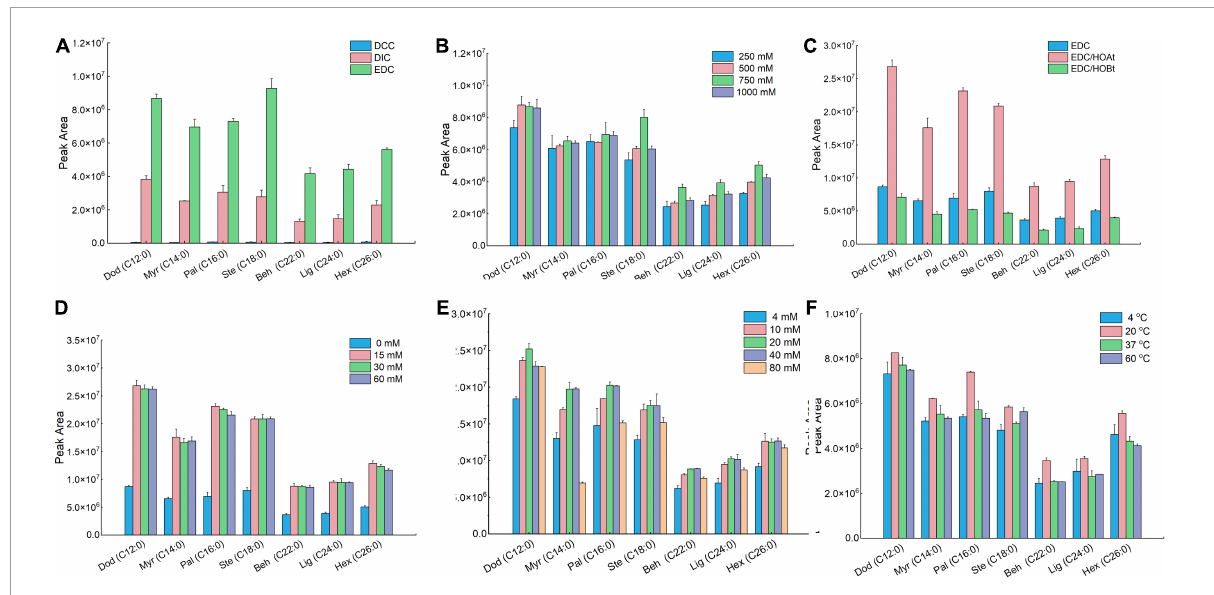
FIGURE2 Comparison of derivatization efficiency of fatty acids (FAs) standard mixture under different reaction conditions. Effect of (A) coupling-reagent types; (B) ethylcarbodiimide hydrochloride (EDC) concentrations; (C) additive types; (D) HOAt concentrations; (E)